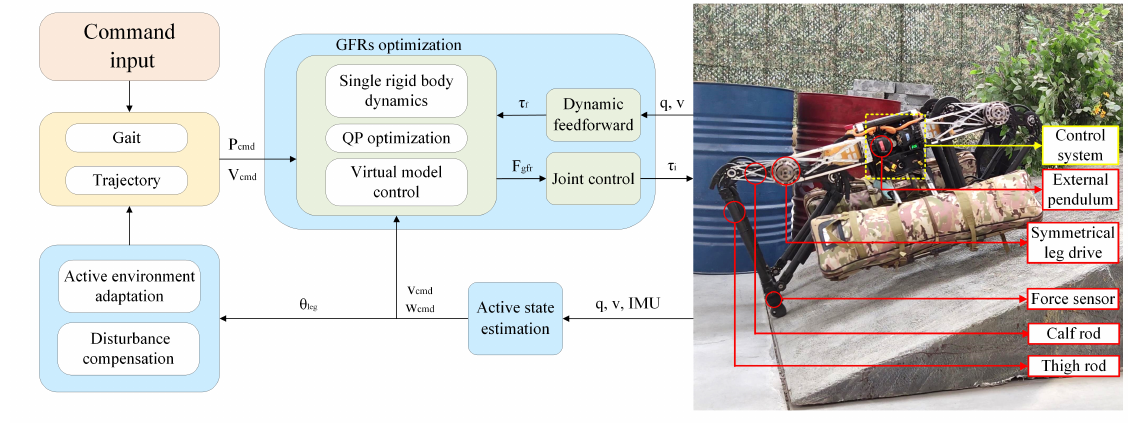
Figure 1. Block diagram of active state adjustment control